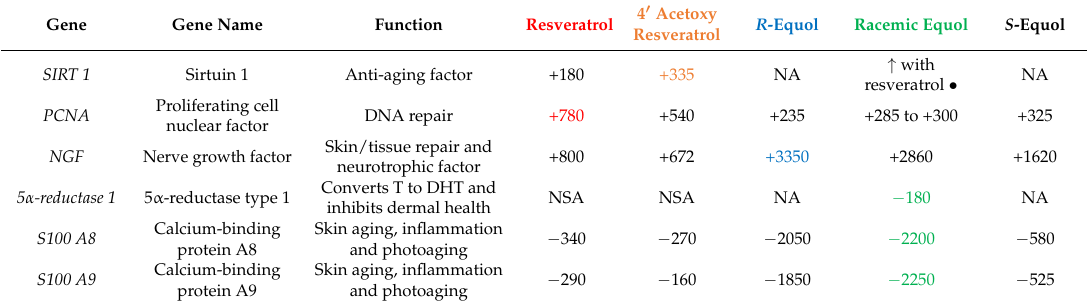
Table 2. Human skin anti-aging gene expression among resveratrol, 4 (cid:48) acetoxy resveratrol, R -equol, racemic equol or S -equol as the percentage of the increase (+) or decrease ( − ) compared to controls. Resveratrol data from [56]; 4 (cid:48) acetoxy resveratrol data from [57]; racemic equol and R -equol and S -equol data from [27,55]; • = data from [57]. NA = not assayed; NSA = no significant alteration in the gene